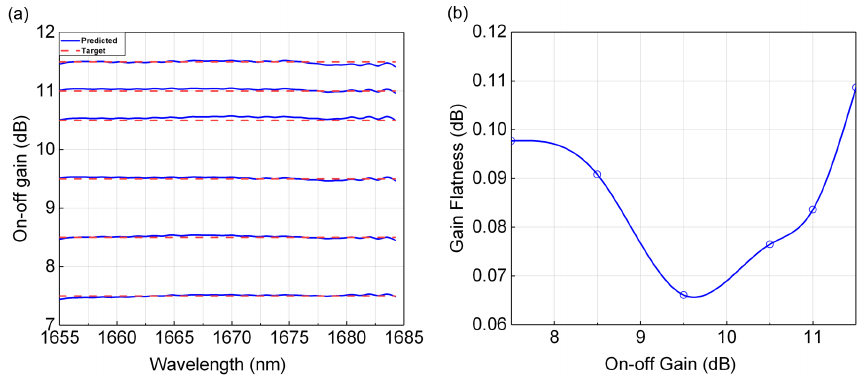
Figure 4. Results for flat gain ( a ) Flat gain spectrum in different On-off gain level ( b ) Gain flatness in different